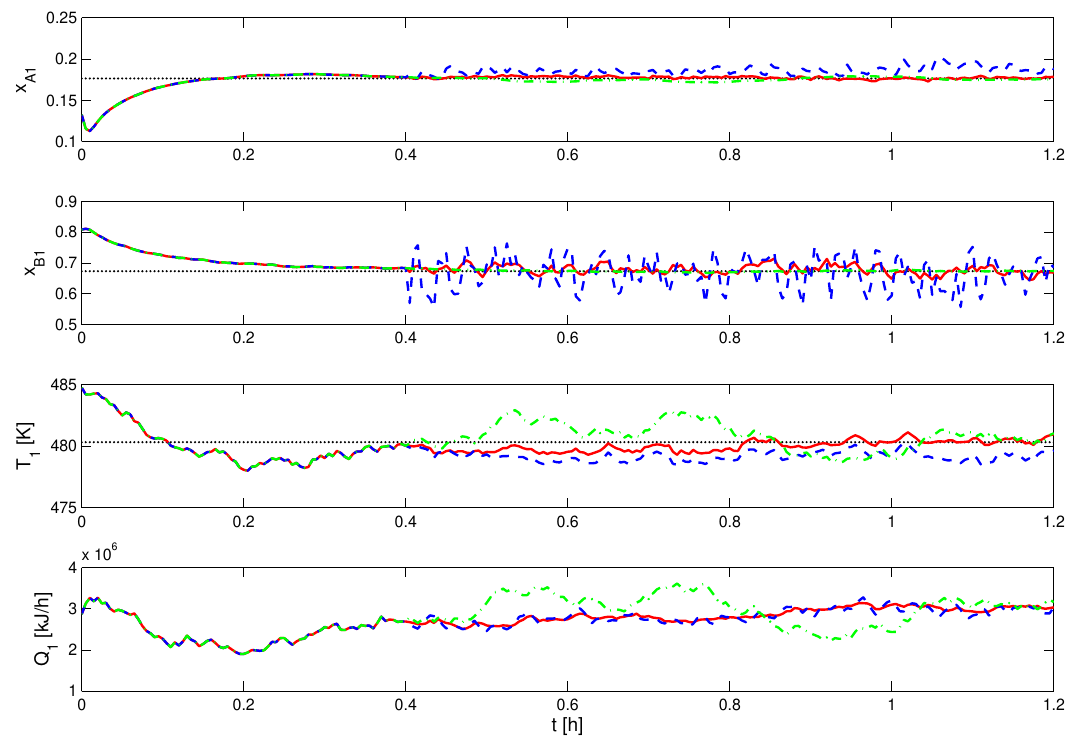
Figure 2. States and input trajectories of subsystem 1 given by the proposed distributed MHE-LMPC (solid line), scheme II (dash-dotted line) and scheme III (dashed line). The set points of states are denoted as dotted line.